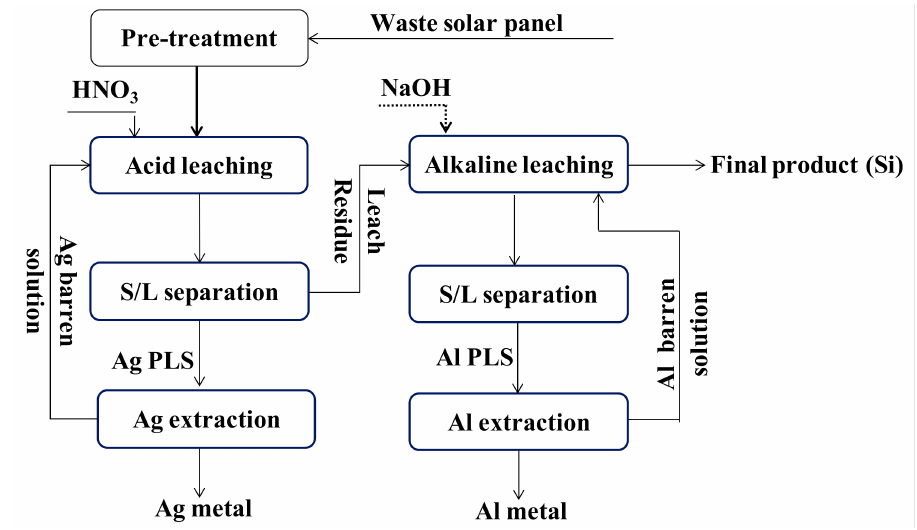
Figure 3. A typical flow sheet for metal leaching from solar panels (Drawn following information from